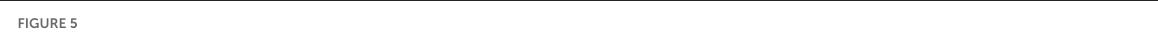
FIGURE5 (G) Bar plot of gut microbiota composition at the genus level. (H–J) The relative abundance of Alistipes, Akkermansia, and Desulfovibrio was significantly changed after orlistat intervention by Metastas analysis. * p < 0.05. LCBD, Local contributions to beta-diversity; LCBD values represent the degree of uniqueness of the sampling units in terms of community composition. NCD, normal diet; HFD, high-fat diet; HFD + ORL, high-fat diet and intervention of orlistat; n = 6 per group.